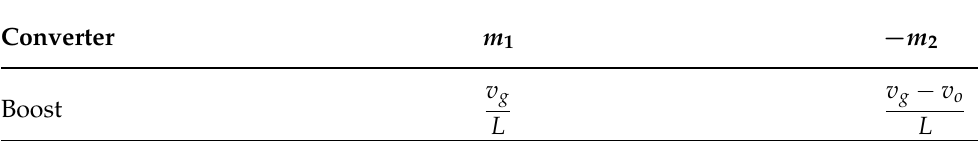
Table 3. Slope of the inductor current